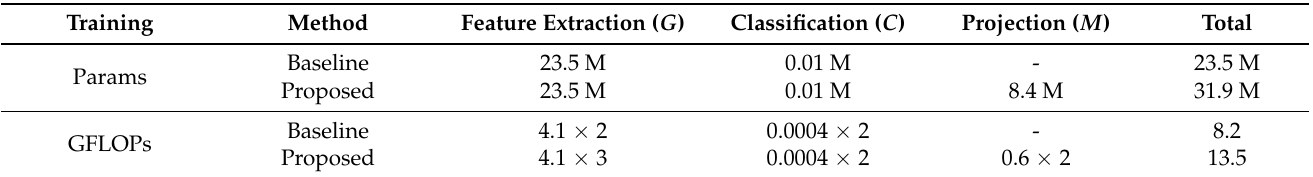
Table 1. Comparisons of the number of baseline [26] parameters and GFLOPs during training. For inference, the proposed method uses the same network as the